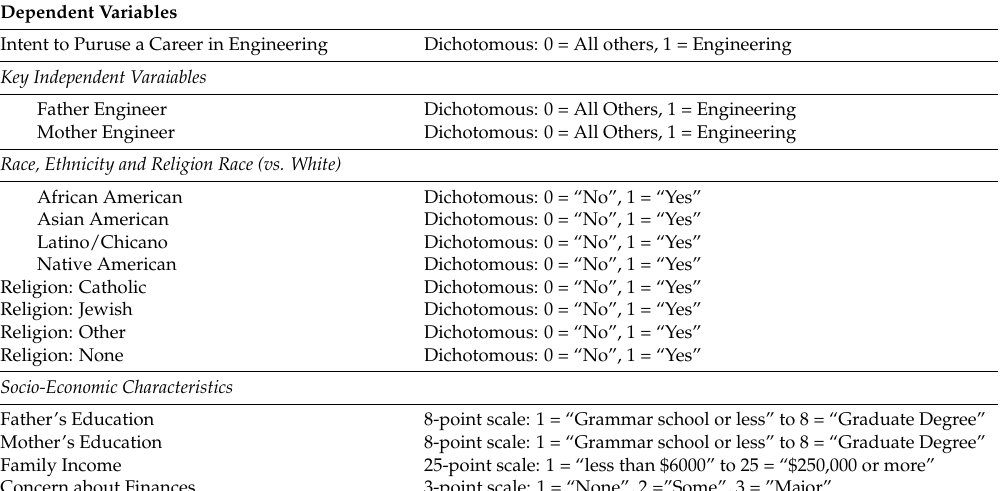
Table A1. Variable List and